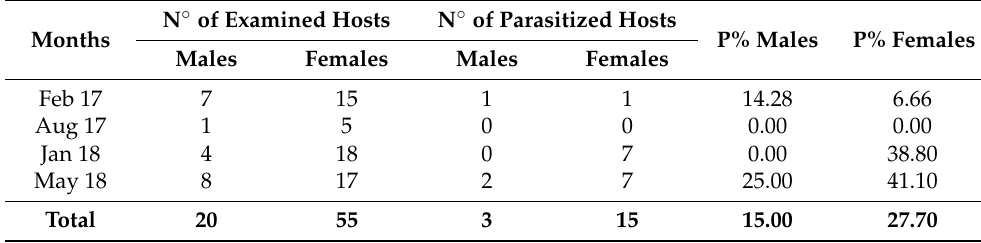
Table 2. Epidemiological indices (upper: prevalence index P% divided for sampling periods and sexes; lower: average abundance (AA) and average intensity (AI) indexes for all 29 parasites found in all the months and sharks collected, 18 of which were Figure 4. Gastrointestinal parasites found in S. canicula in the present study. ( A ) Nybelinia sp. (Few,